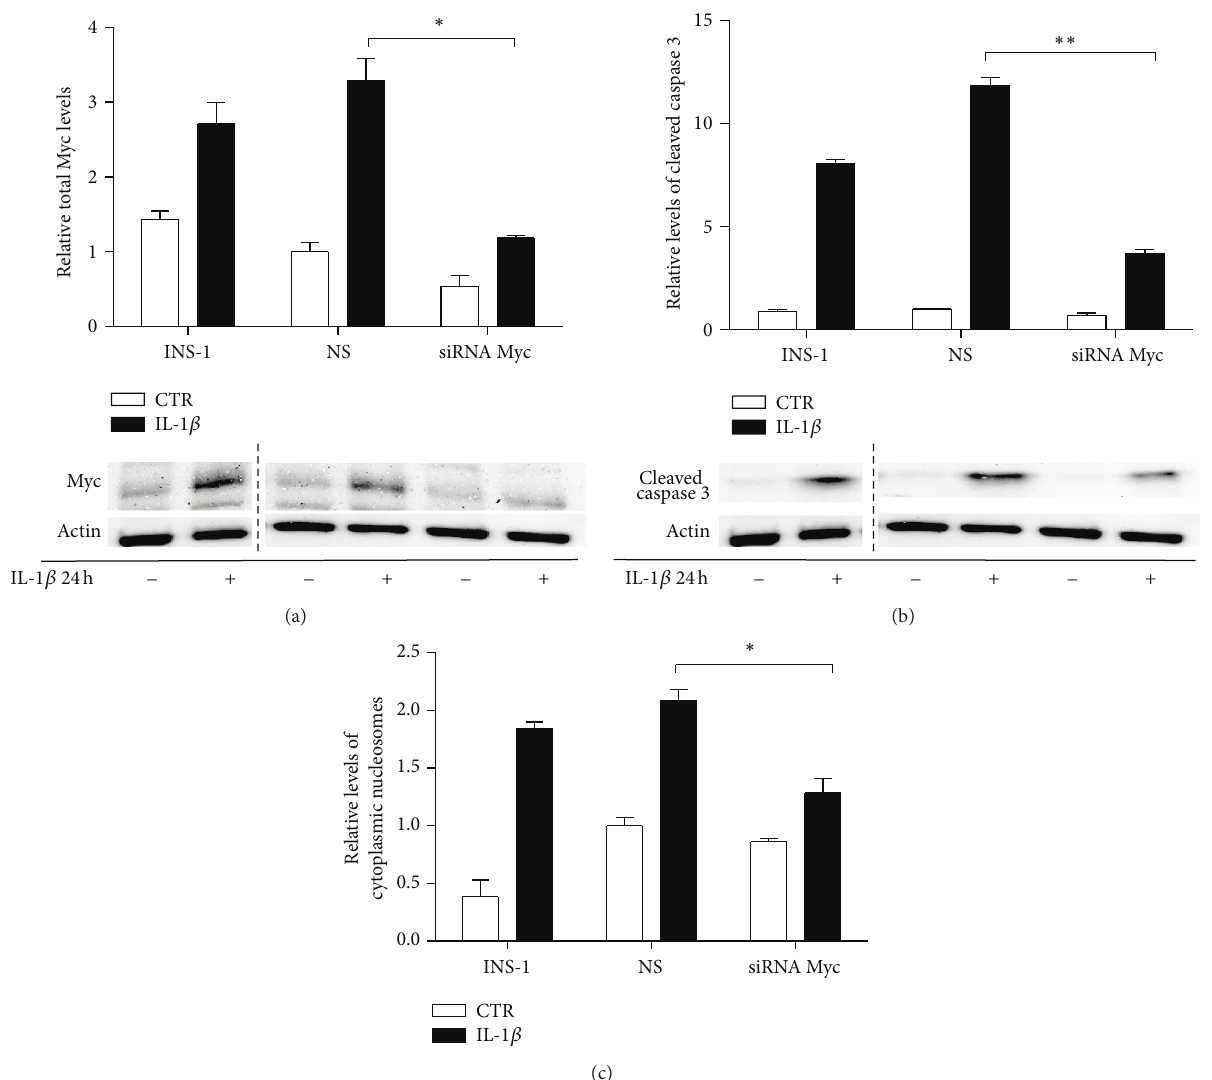
Figure 7: Myc knockdown attenuates IL-1 𝛽 -induced apoptosis in INS-1 cells. INS-1 cells were transfected with siRNA directed against Myc, a scrambled siRNA control (NS) or vehicle (INS-1) for 16h. Thereafter, cells were exposed to 150pg/mL IL-1 𝛽 (closed bars) or vehicle (open bars) for 24 h. (a) Total Myc protein levels and (b) cleaved caspase 3 were analyzed by immunoblotting. Actin was used as the loading control. Data are shown as means ± SEM of 3-4 independent experiments. Blots shown are representative. (c) Apoptosis was measured as relative levels of cytoplasmic nucleosomes in lysates measured by the Roche Cell Death Elisa kit. Data are shown as means ± SEM of 3-4 independent experiments. ∗ 𝑃 < 0.05 and ∗∗ 𝑃 < 0.01 versus IL-1 𝛽 exposed